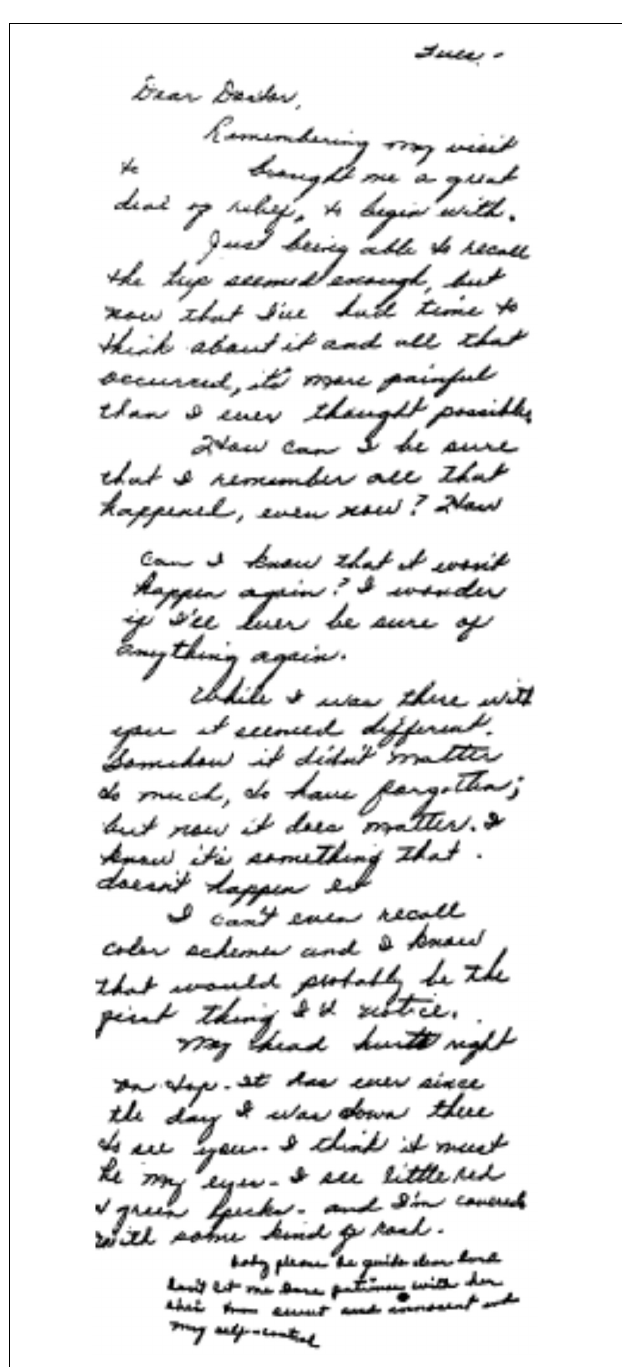
FIGURE 1 | The letter sent to the psychiatrists involved in the case of Chris Sizemore by the patient, Mrs. Sizemore. The sudden change in the handwriting can be observed in the last paragraph of the